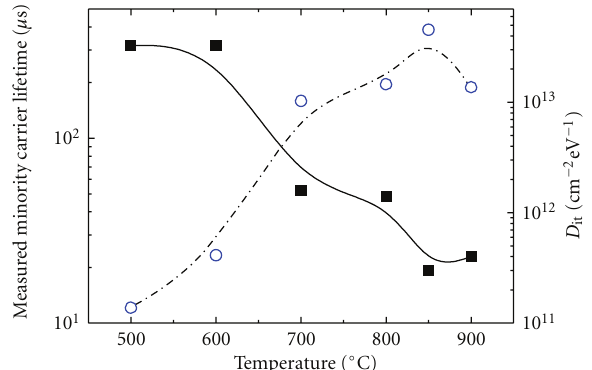
Figure 2: Variation of e ff ective lifetime and interface trap density ( D it ) as a function of rapid thermal annealing